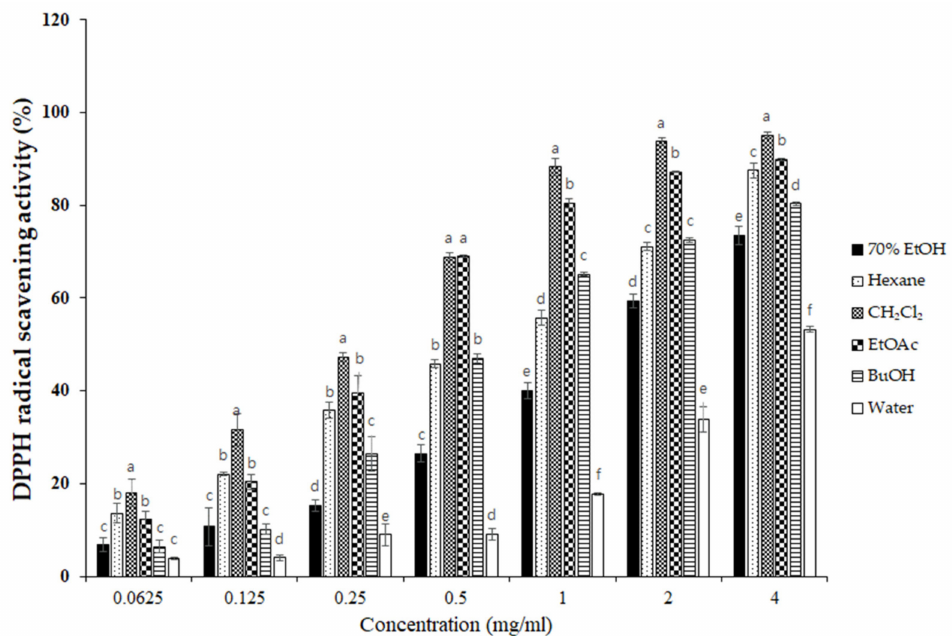
Figure 3. Effects of S. horneri extract and its fractions on DPPH radical scavenging activity. The measurement of DPPH radical scavenging activity is described in the Materials and Methods section. All data represent mean values of 3 independent experiments ± SD. Data were statistically considered at p < 0.05, and different letters (a–f) in graph represent statistical difference.